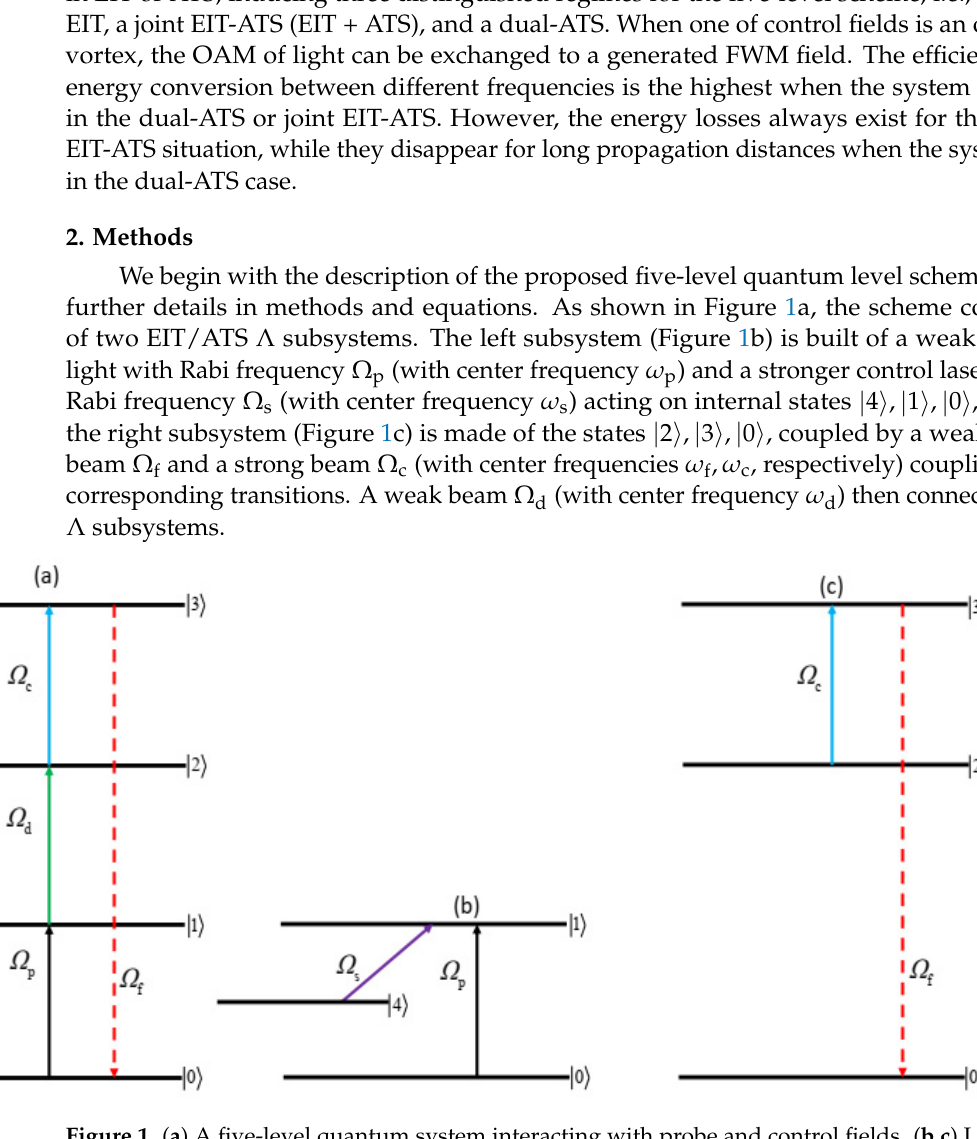
Figure 1. ( a ) A five-level quantum system interacting with probe and control fields. ( b , c ) Left and right Λ subsystems.